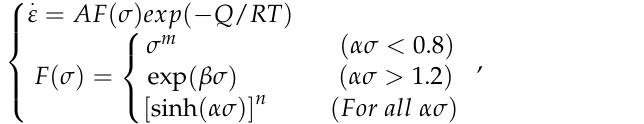
( b ) Figure 4. Relationship between: ( a ) ln 𝜀̇ and ln𝜎 ; ( b ) ln 𝜀̇ and 𝜎 .